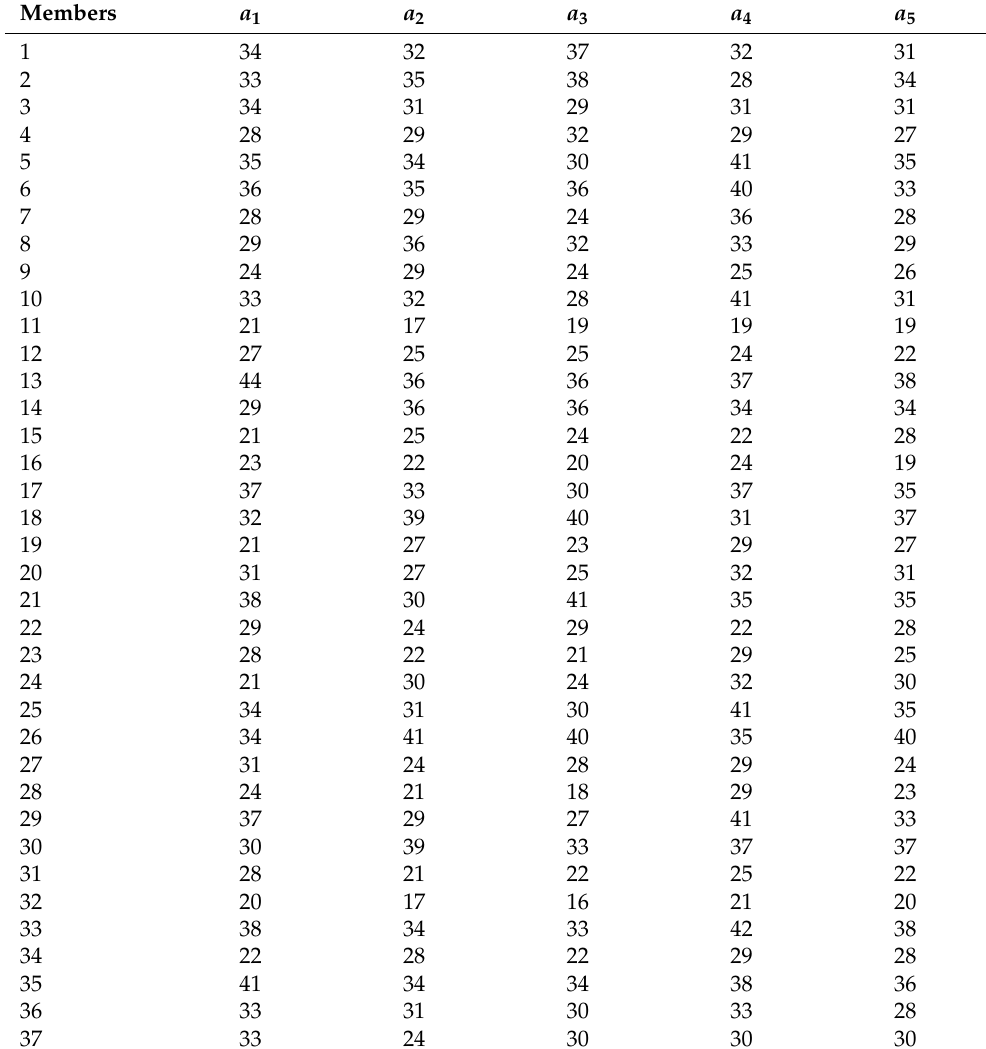
Table 2. Competency scores of the 37 alternative